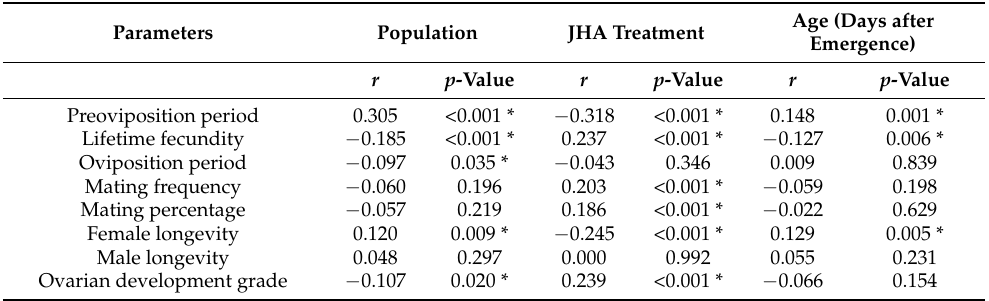
Age (Days after Emergence)